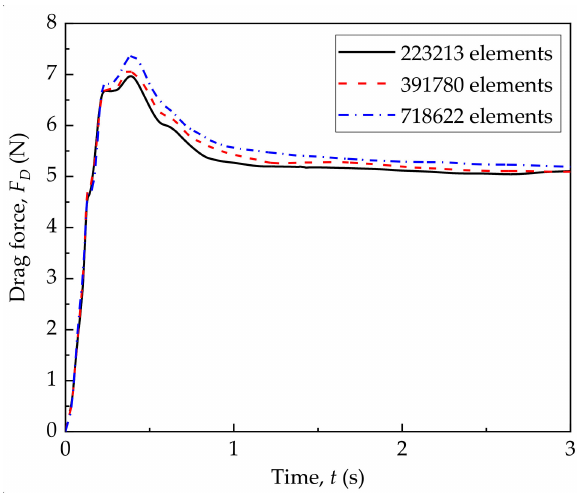
Figure 4. Mesh sensitivity analysis results. The domains were set up for two-phase flow. The Herschel–Bulkley rheological prop- erties of the submarine debris flows in the flume experiments given in Table 1 and standard properties of water were used in the simulations, respectively. Turbulence generated in the two-phase flow was simulated using the κ - ω model. The difference between two-phase flow velocities produces phase interaction at the contact surface. The phase interaction was set as drag coefficient. The total time of simulation was 3–10 s (related to mud velocity), and the time step was 0.0005 s. The transient formulation and spatial discretization were taken as the second order form. Table 1. Composition and rheological properties of submarine debris flows adapted from Feng et al.